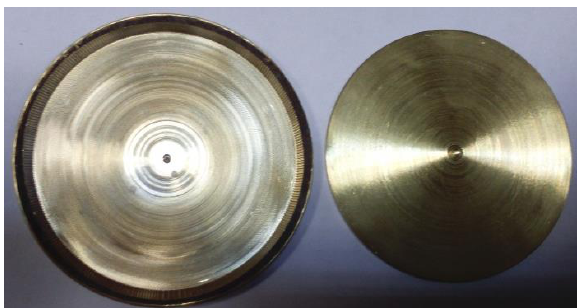
Fig. 4. Blank with a shoulder (left) and after processing without a shoulder (right).